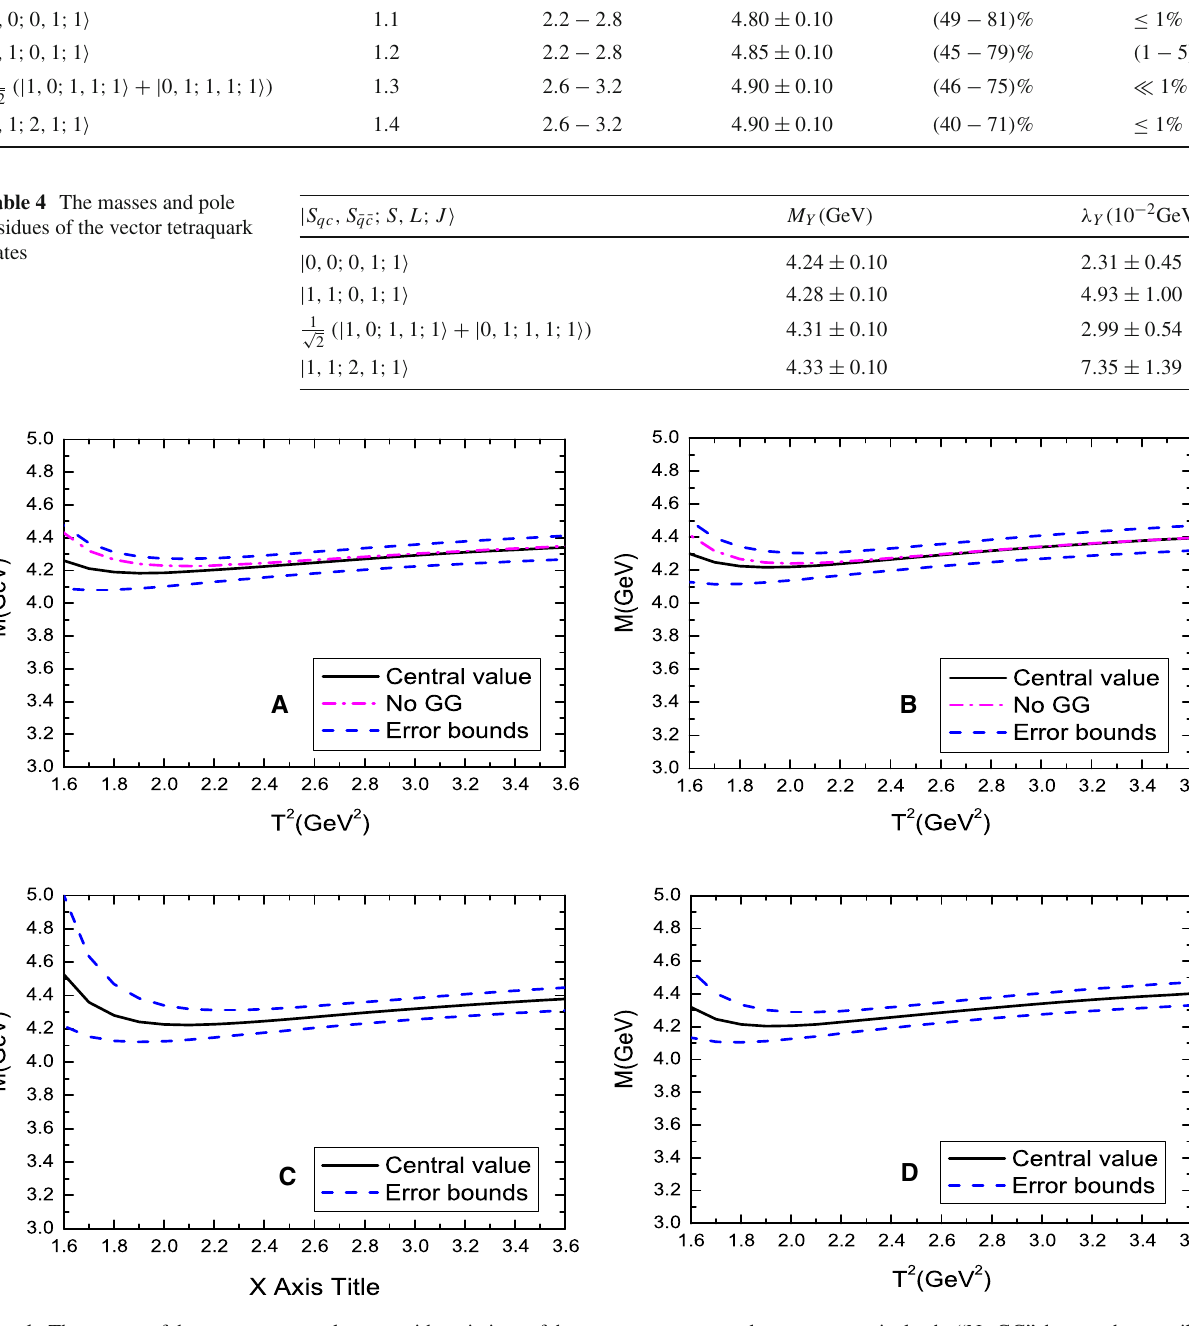
vectortetraquarkstates,respectively,the“NoGG”denotesthecontribu- tionsofthevacuumcondensates (cid:9) α s GG π (cid:8) , (cid:9)¯ qq (cid:8)(cid:9) α s GG π (cid:8) and (cid:9)¯ qq (cid:8) 2 (cid:9) α s GG π (cid:8) are